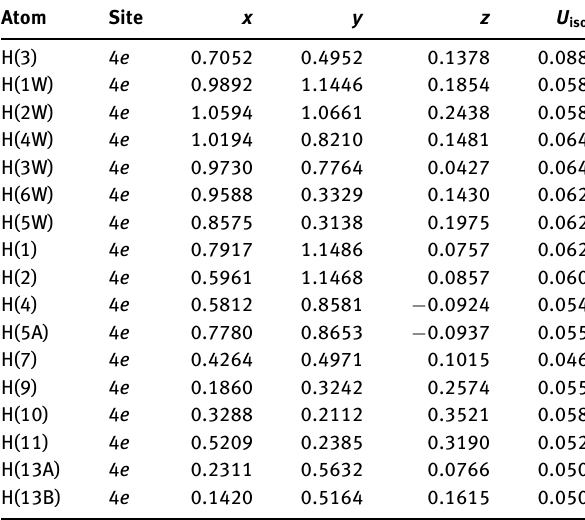
Table 2: Atomic coordinates and displacement parameters (in Å 2